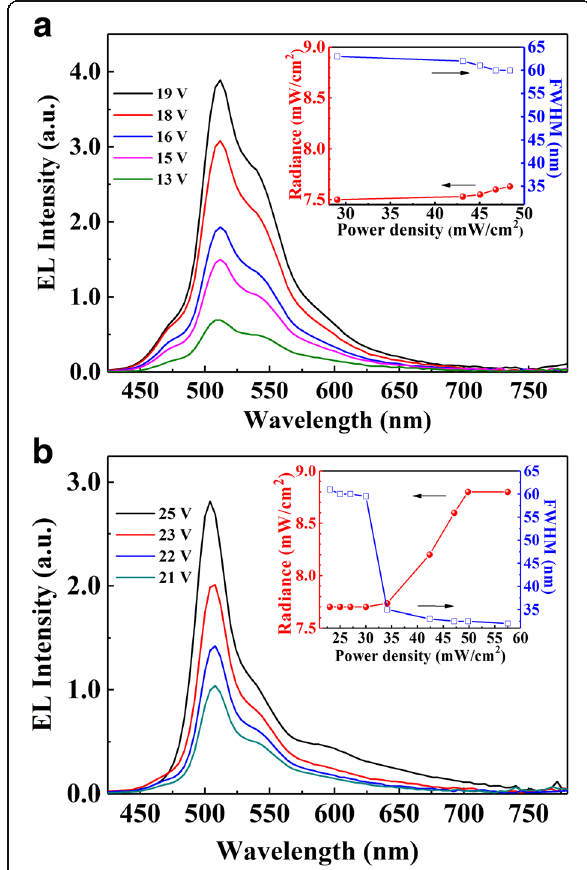
Fig. 6 Evolution of EL spectra with increasing voltage of electrically pumped device E a and device F b . The insets show the dependences of radiance and FWHM at various power